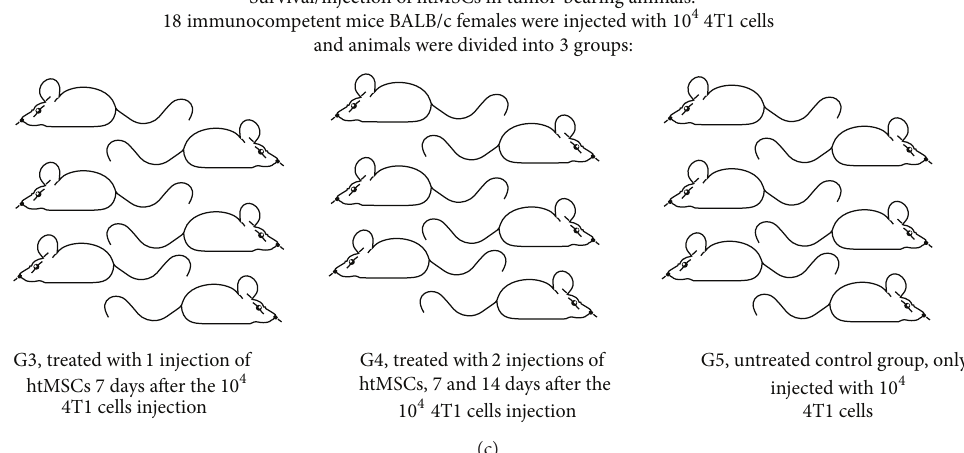
Figure 1: Experimental design, where (a) represents the coinjected group; (b) and (c) represent tumor-bearing animals injected with htMSCs.